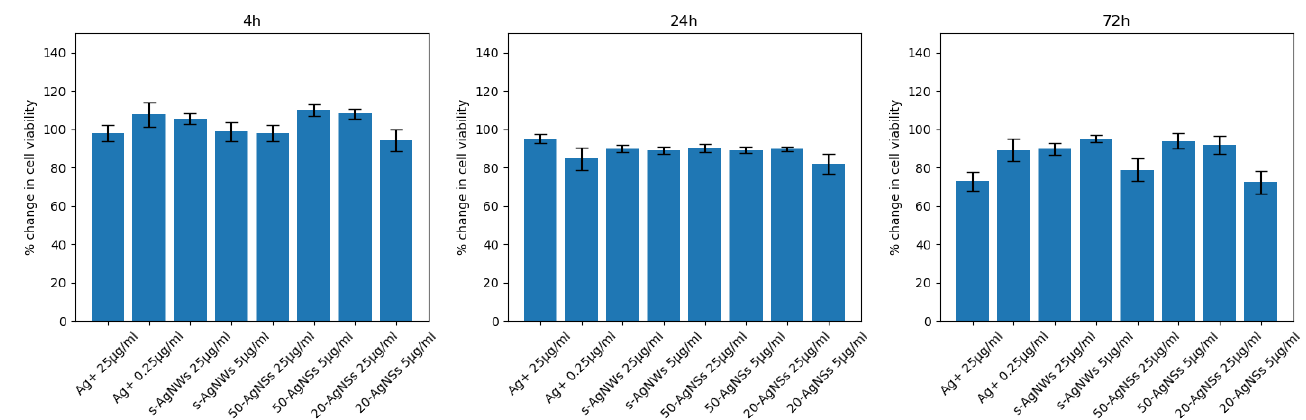
Figure 23. Concentration and time-dependent predictions of AgNSs and AgNWs, and Ag + ions on ASM cell viability after 4 h, 24 h and 72 h. The bars represent mean values of 10 predictions made using a WGAN and the whiskers indicate standard error of the mean (SEM).